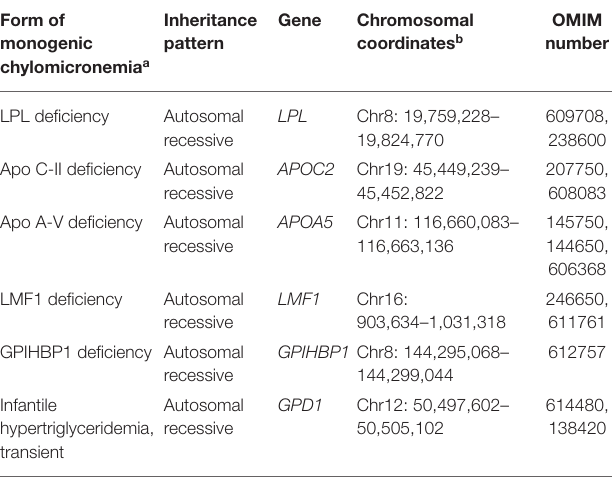
TABLE 1 | Defining the molecular subsets of monogenic chylomicronemia. Form of